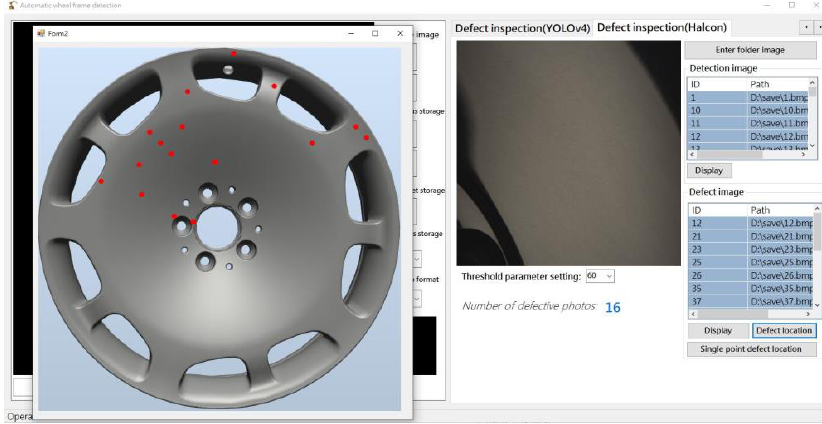
Figure 9. Test results interface.